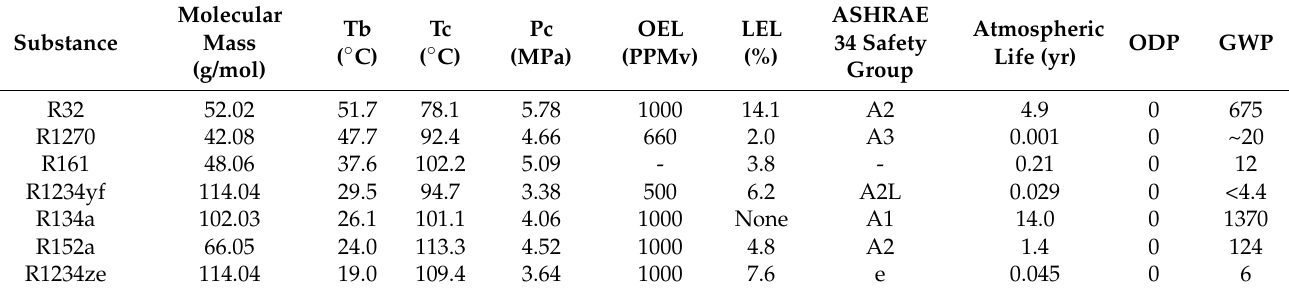
Table 1. Physical, safety and environmental data of the refrigerants